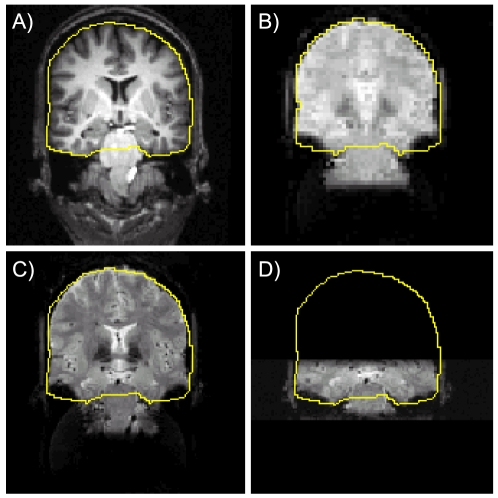
Signal drop-out is worse in low-resolution images because thicker slices result in more signal loss due to drop-out, and distortion is worse in full FOV high resolution images due to long read-out times.(A) Reference anatomy; yellow line is for visual reference and the same in all 4 panels. (B) Conventional low resolution EPI (3 mm isotropic voxels; total read-out, TRO = 22.5 ms; echo time, TE = 25 ms). Signal from lateral inferior temporal lobe is missing. (C) Full FOV high resolution image (TRO = 66.6 ms; TE = 37 ms). A combination of signal displacement and signal loss affects lateral temporal cortex. Note tissue signal from medial temporal cortex extends bilaterally below fiducial lines. (D) Zoomed FOV image (TRO = 16.6 ms; TE = 25 ms). Both distortion and signal loss are minimized.